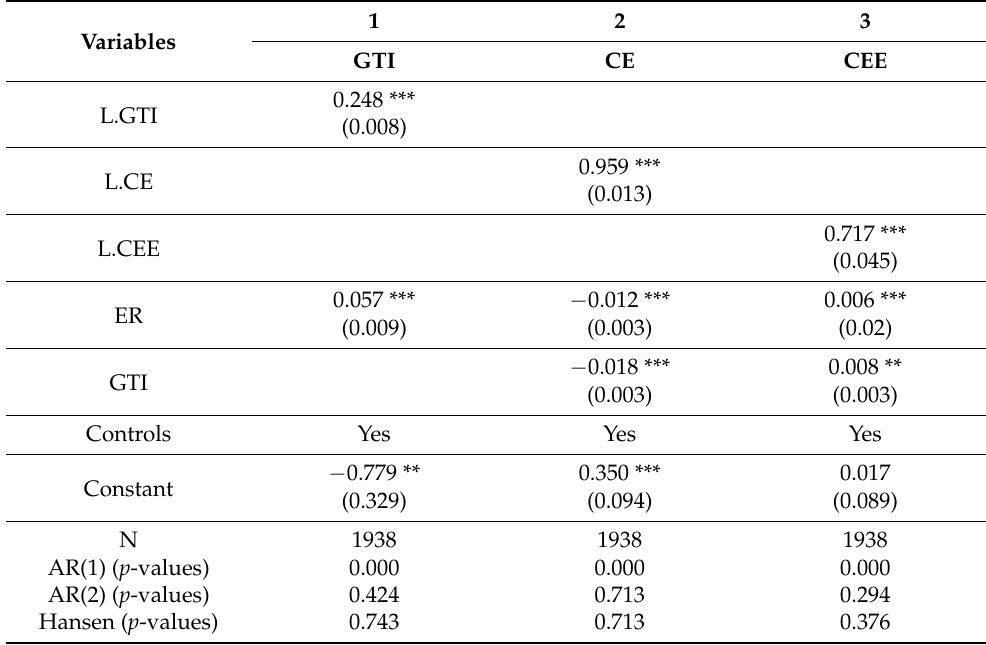
Table 6. Regression results of mechanism analysis for green technology